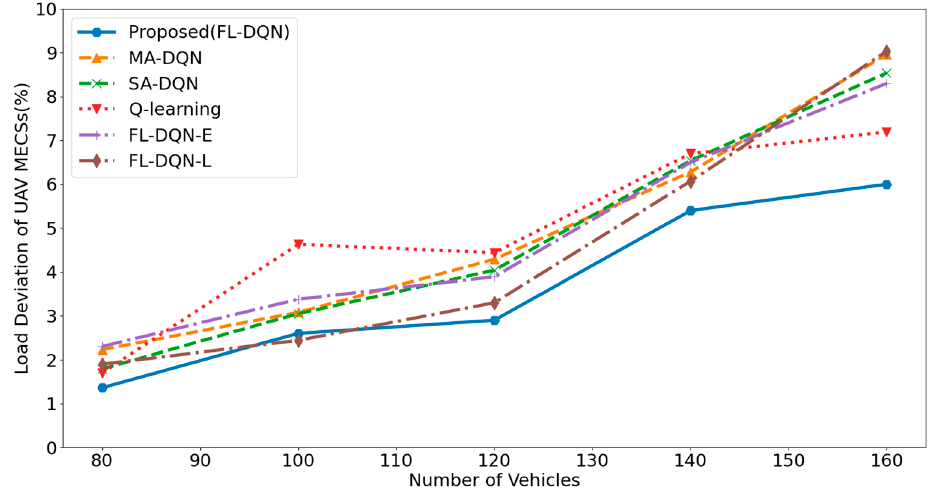
Figure 3. Load deviation of UAV MECSs with varying number of vehicles.